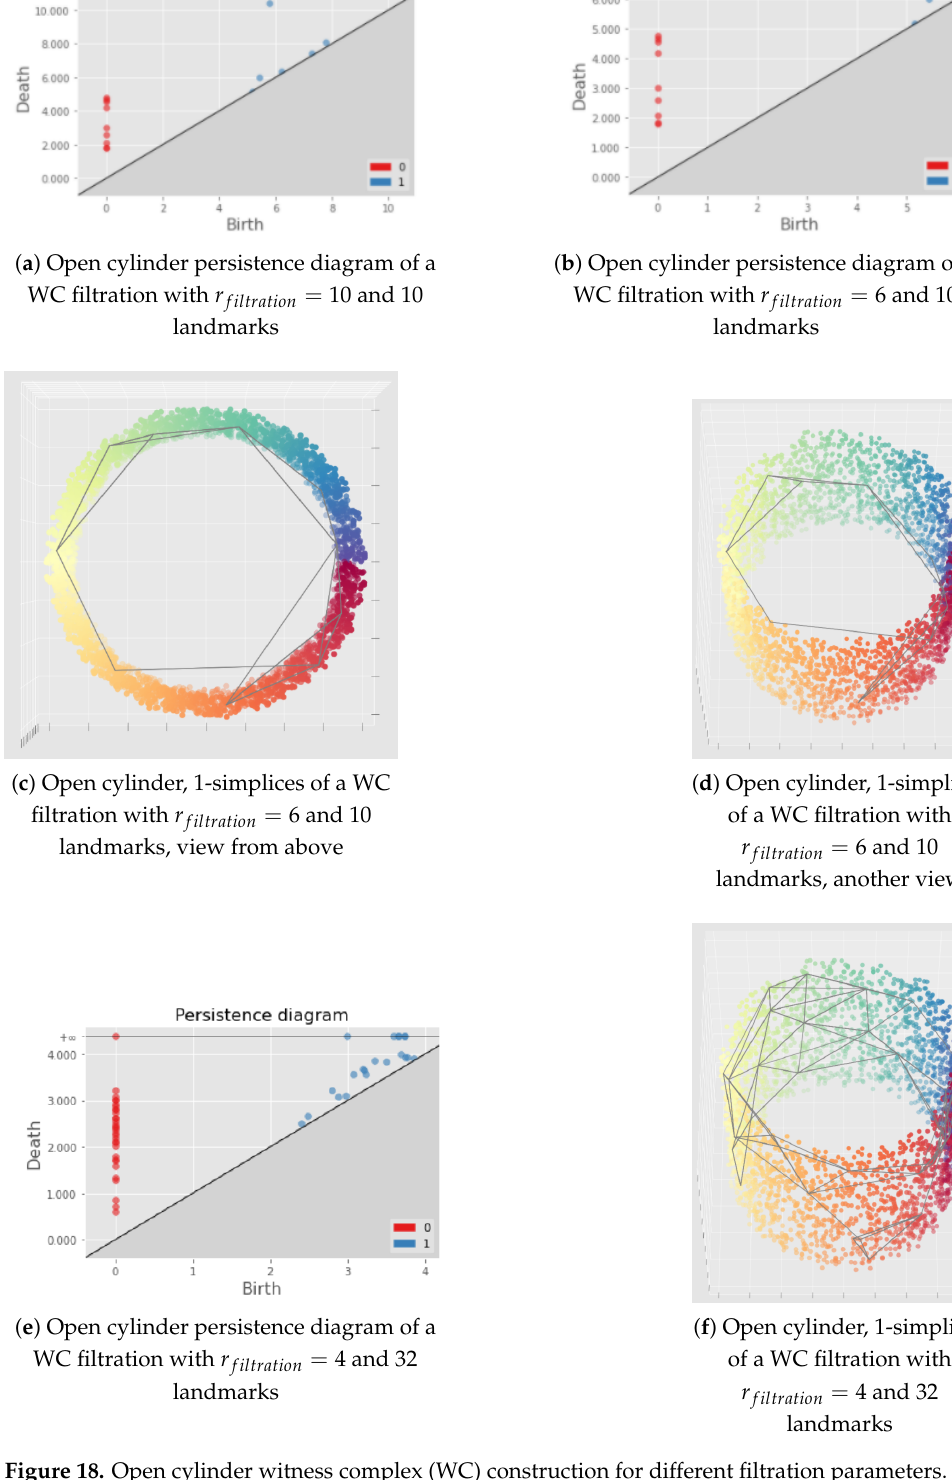
Figure 18. Open cylinder witness complex (WC) construction for different filtration parameters. For the persistence diagrams ( a , b , d ), on the x and y axis are the radius filtration, red points represent Betti 0 (connected components) and blue points represent Betti 1 (1-dimensional holes). In images ( c , d , f ) are shown only the 1-dimensional simplices (grey edges) of the witness